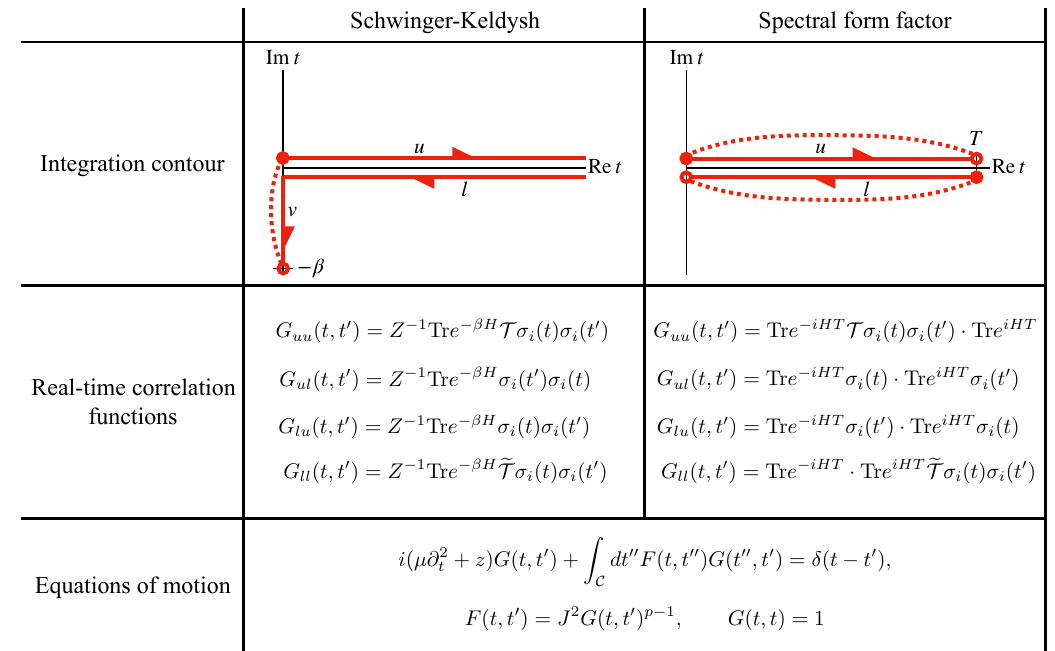
Figure 4 . Summary of the contours, order parameters, and (at least at high temperature) equations of motion considered in this work. The left column gives the quantities appropriate to the Schwinger- Keldysh path integral, and the right column to the spectral form factor (SFF) path integral. (Top row) Contours for the respective path integrals. Each of the different branches is labelled, and directions are indicated by arrowheads. Points connected by dashed lines are identified, making the contours periodic. (Middle row) Relationship between order parameters of the theory and observable quantities. H and Z are the p -spin Hamiltonian and partition function respectively. T and e T denote time ordering and anti-ordering. (Bottom row) Equations of motion. These take the same form for both path integrals, differing only in the contour C being